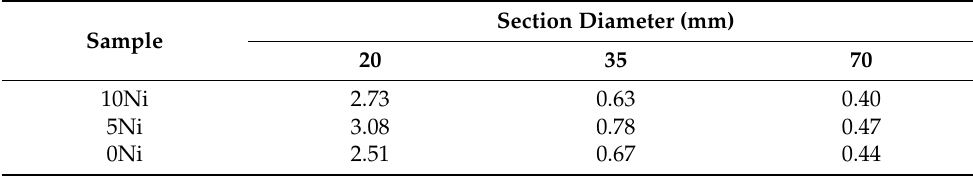
Table 9. Sample cooling rates